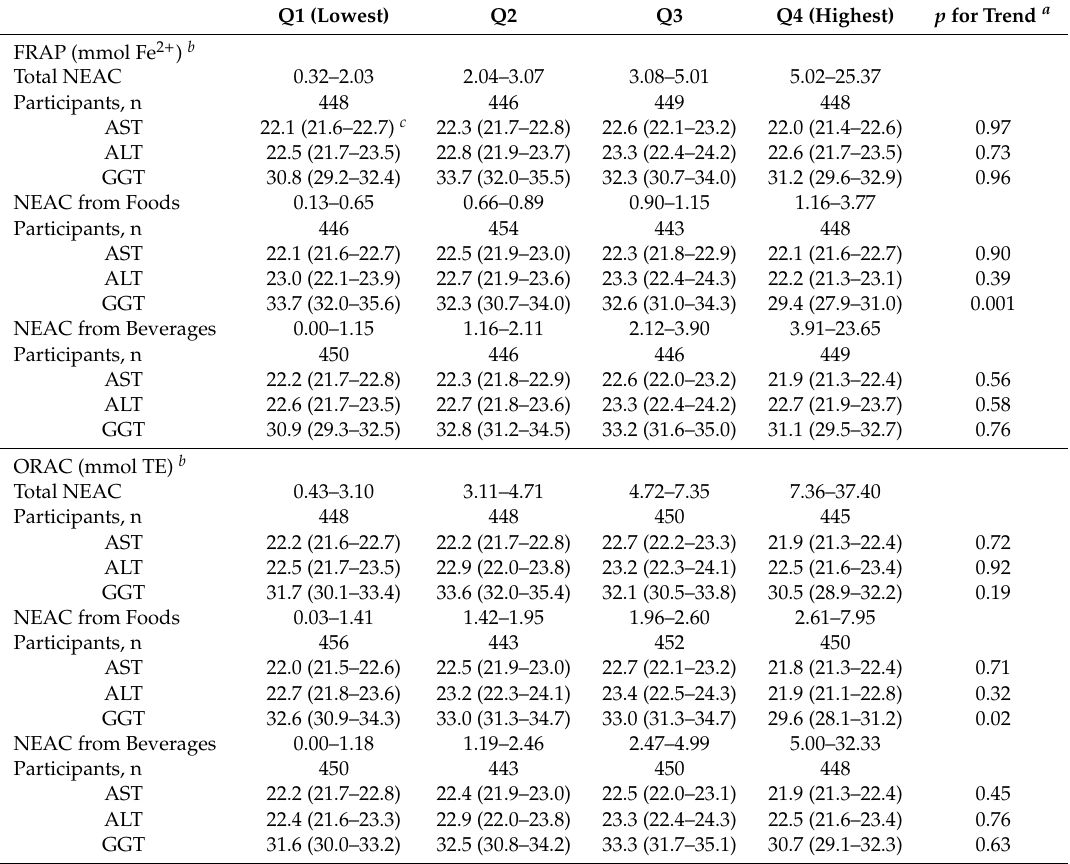
Table 3. Geometric means (95% CI) of serum liver enzyme levels according to quartiles (Q) of overall dietary NEAC and NEAC from foods and